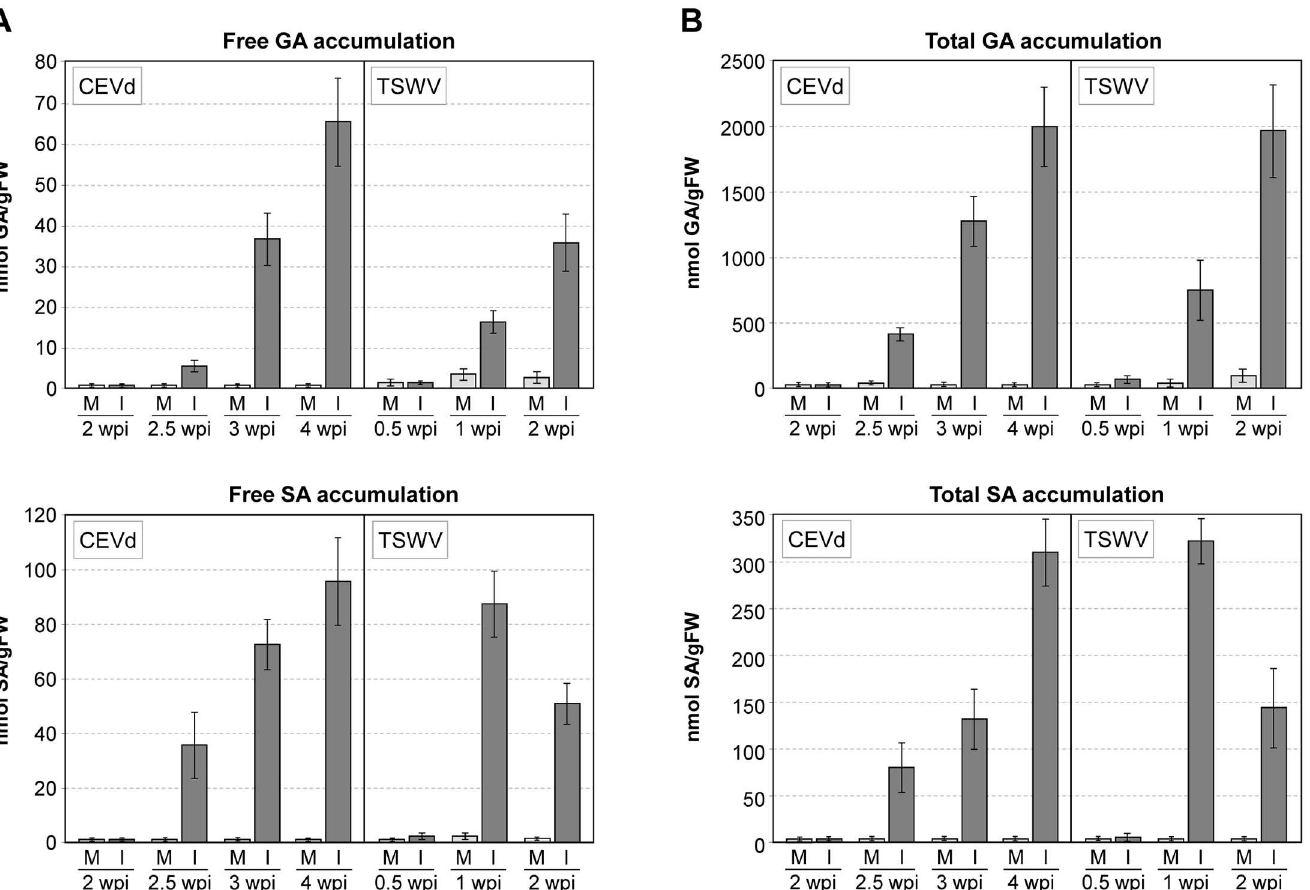
Fig 1. Accumulation of phenolic compounds in Money Maker plants infected with citrus exocortis viroid (CEVd) or tomato spotted wilt virus (TSWV). Levels of free A) and total B) gentisic acid (GA) and salicylic acid (SA) in mock-inoculated and infected Money Maker tomato leaves. Plants were inoculated with either CEVd or TSWV and sampleswere collectedat the indicatedtimes (weeks post-inoculation, wpi) for both infected (I) and mock- inoculated (M) leaves, and then analyzedby HPLC-fluorescence detection. Total SA is the sum of free SA and SA glucosideand total GA is the sum of free GA and GA xyloside. Data correspondto the mean ± SD of three biologicalreplicatesof one representative experiment. The experiments were repeated at least 3 times.